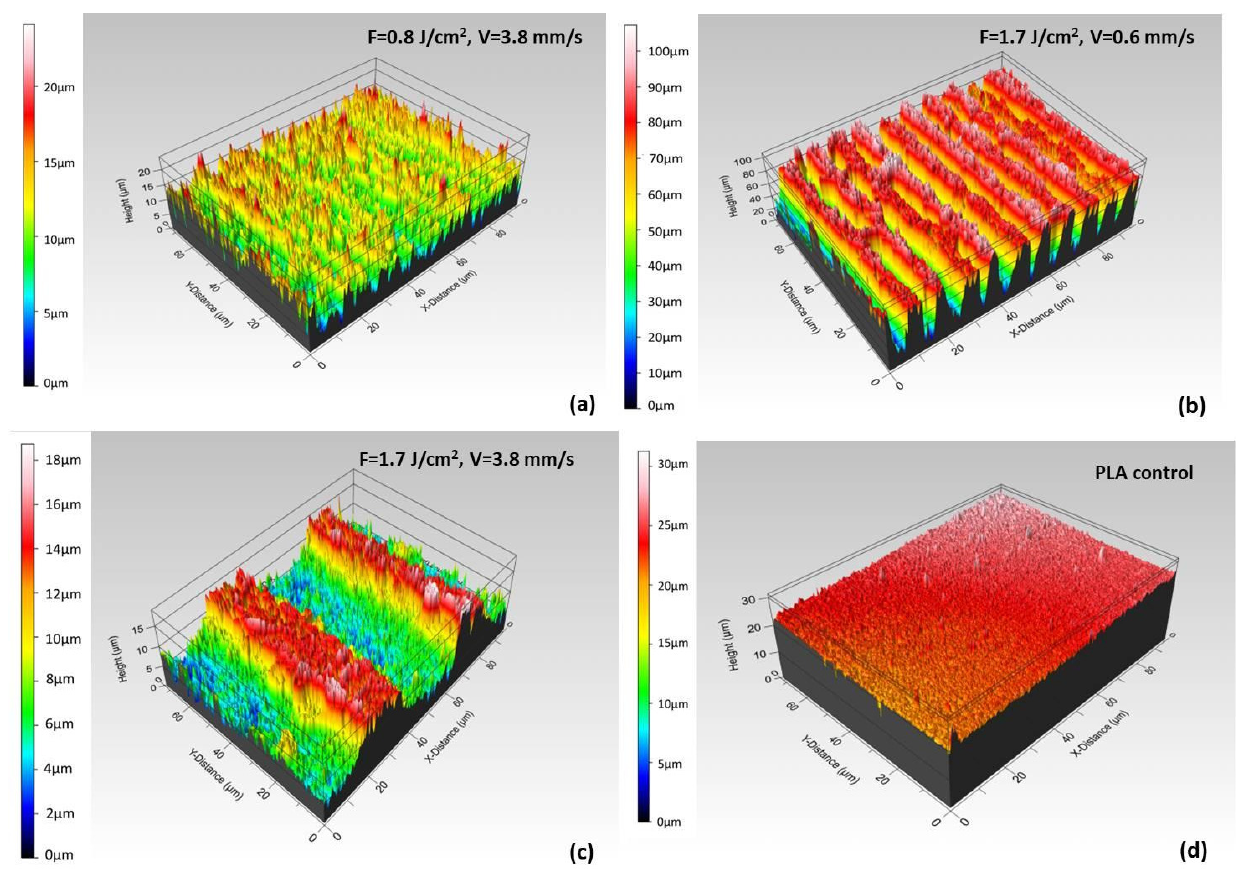
Figure 7. Representative 3D cross section images of PLA matrices: ( a ) F = 0.8 J/cm 2 , V = 3.8 mm/s, ( b ) F = 1.7 J/cm 2 , V = 0.6 mm/s, ( c ) F = 1.7 J/cm 2 , V = 3.8 mm/s; ( d ) control surface.